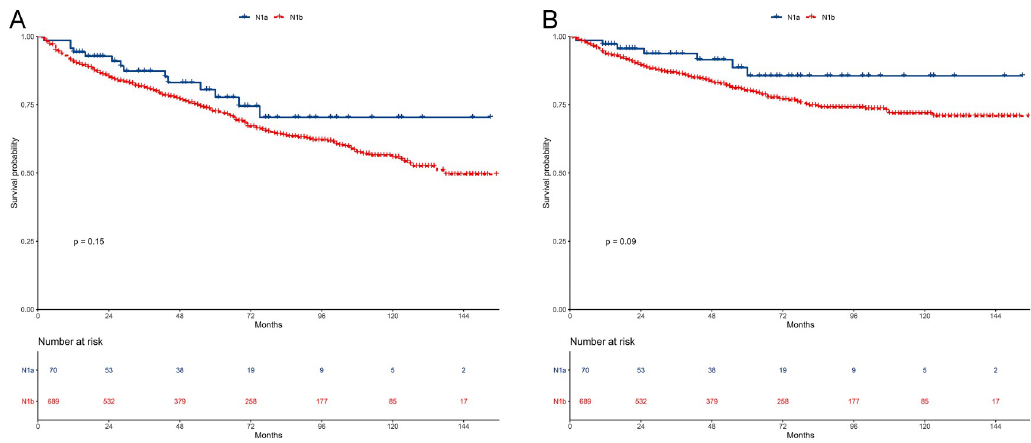
https://doi.org/10.1371/journal.pone.0253424.g002